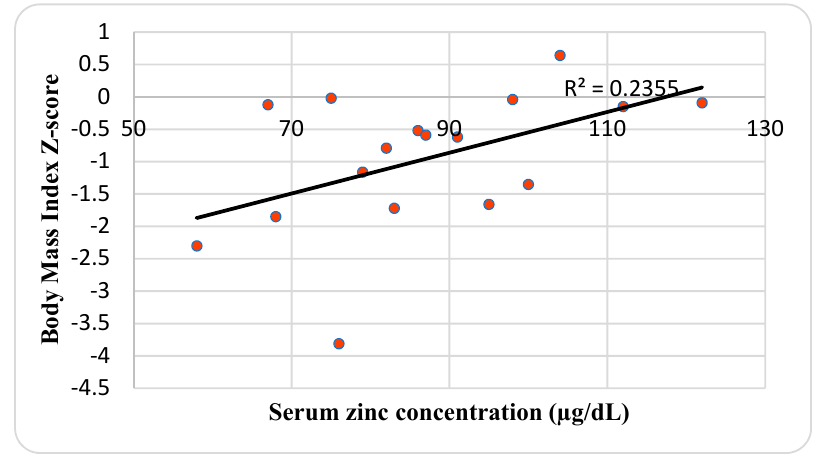
R² = 0.2355 R² = 0.2355